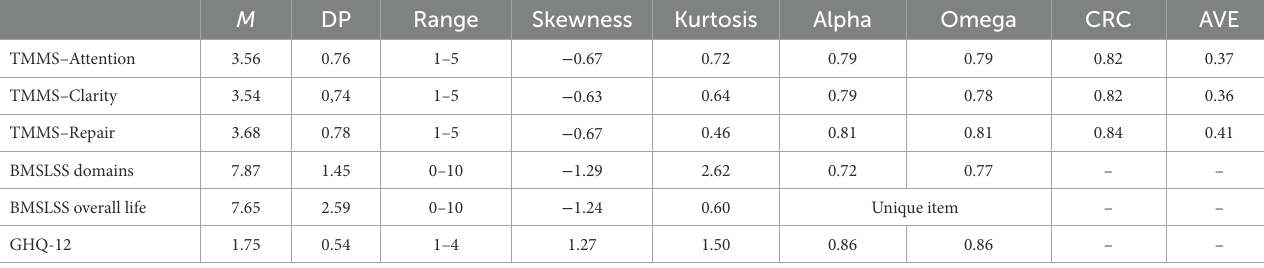
TABLE 4 Descriptive analysis and reliability indices of the scales in the study. M DP